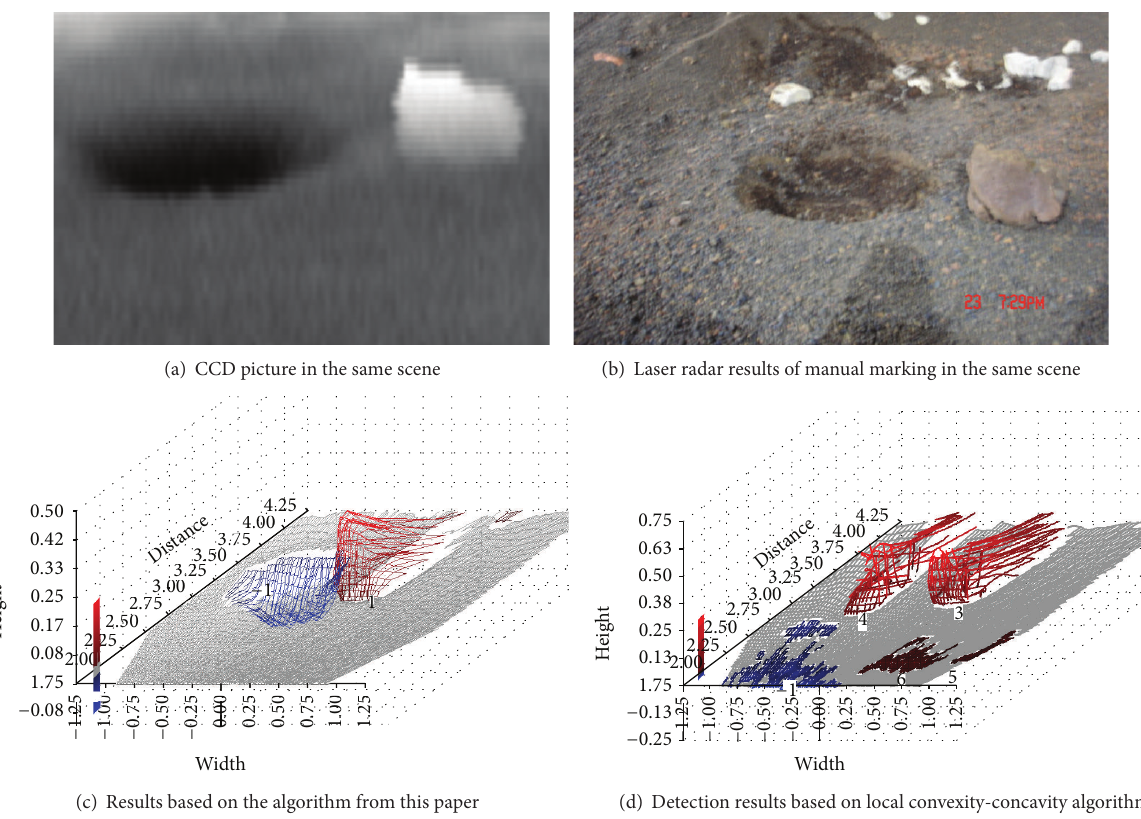
(d) Detection results based on local convexity-concavity algorithm Figure 9: The results of positive and negative obstacles in the cross-country environment.